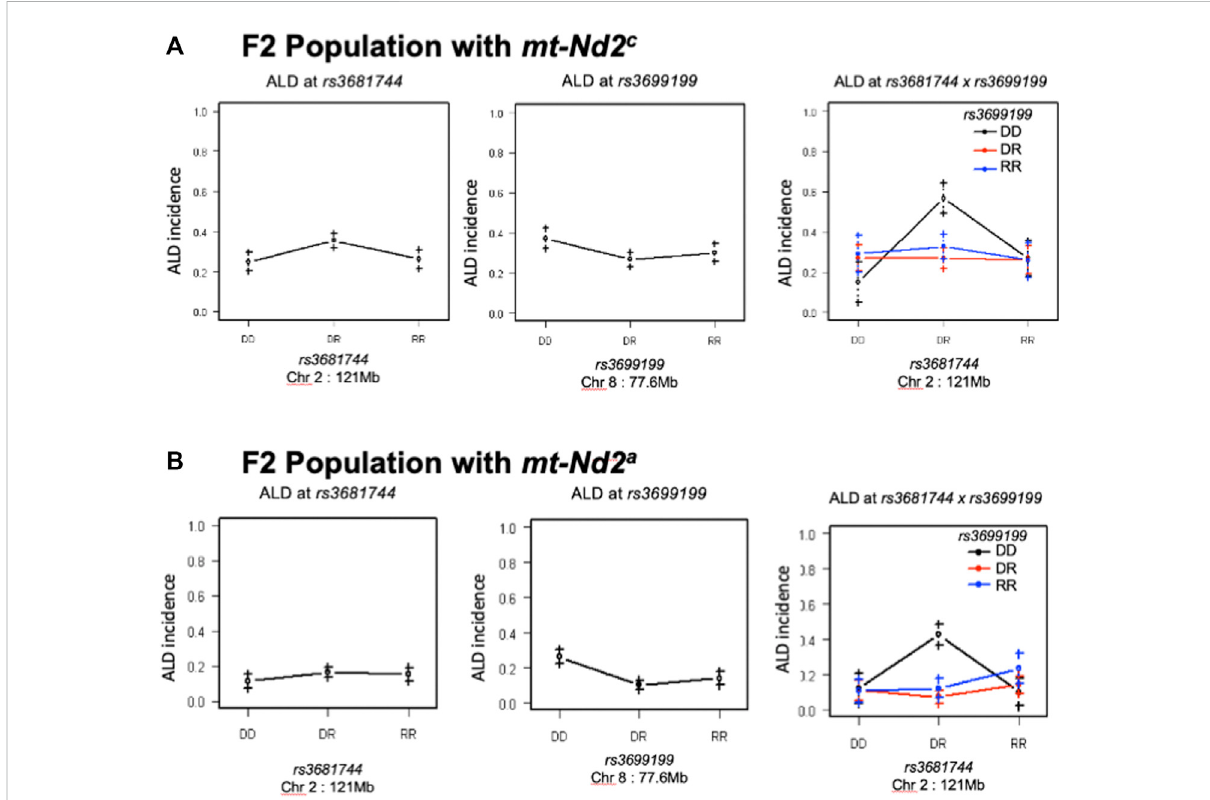
FIGURE 6 The interaction between Chr 8 and 2 were analyzed in 2 subgroups according to mt-genotype. Panel (A) , interaction in the subgroup of mice with mt-Nd2 c type.LeftandmiddlearetheeffectsofQTLonChr2and8respectively.Rightplotshowstheirjointeffectswithchr2genotypesonthe x -axis and chr 8 genotypes indicated by grouping of points (DD, black; DR, red; and RR, blue). Panel (B) , the same analysis as in Panel A was done in the group of mice with mt-Nd2 a